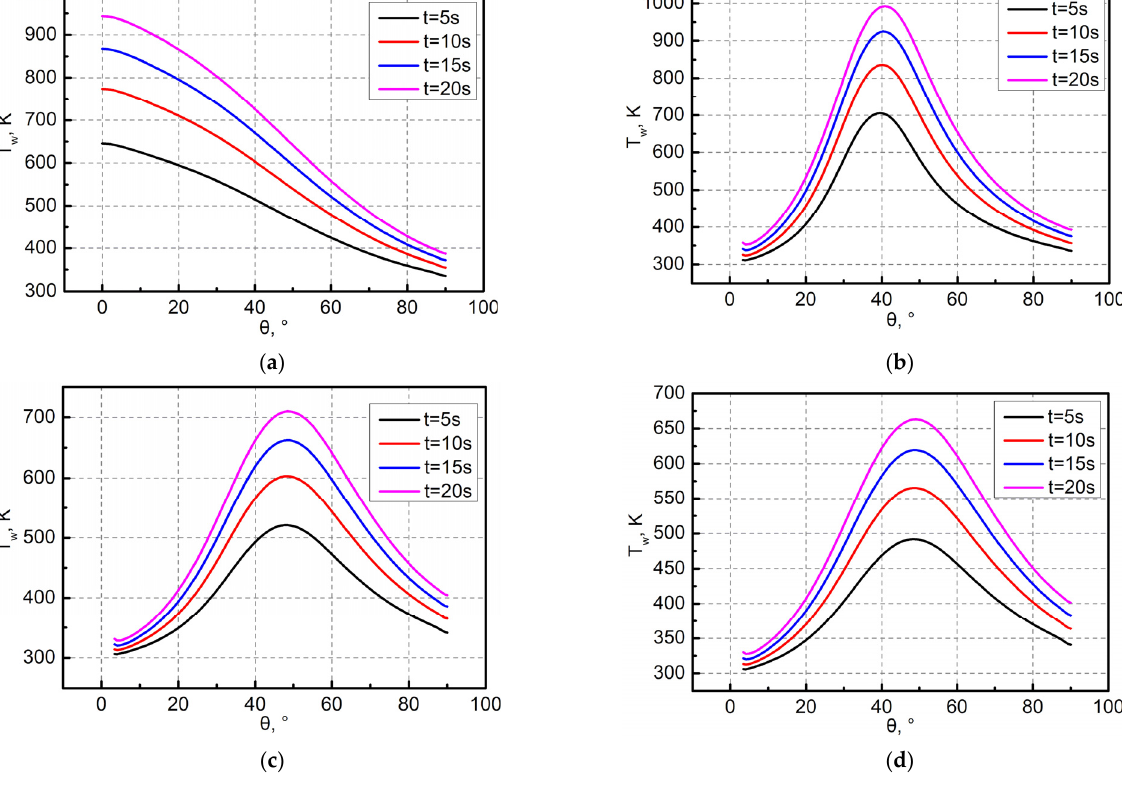
Figure 12. Evolution of wall temperature of the forebody: ( a ) Model 1; ( b ) Model 2; ( c ) Model 3; ( d ) Model 4.